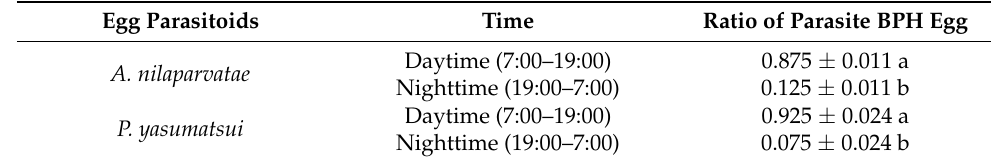
Table 3. Parasitism activity of the two egg parasitoids during day and night.